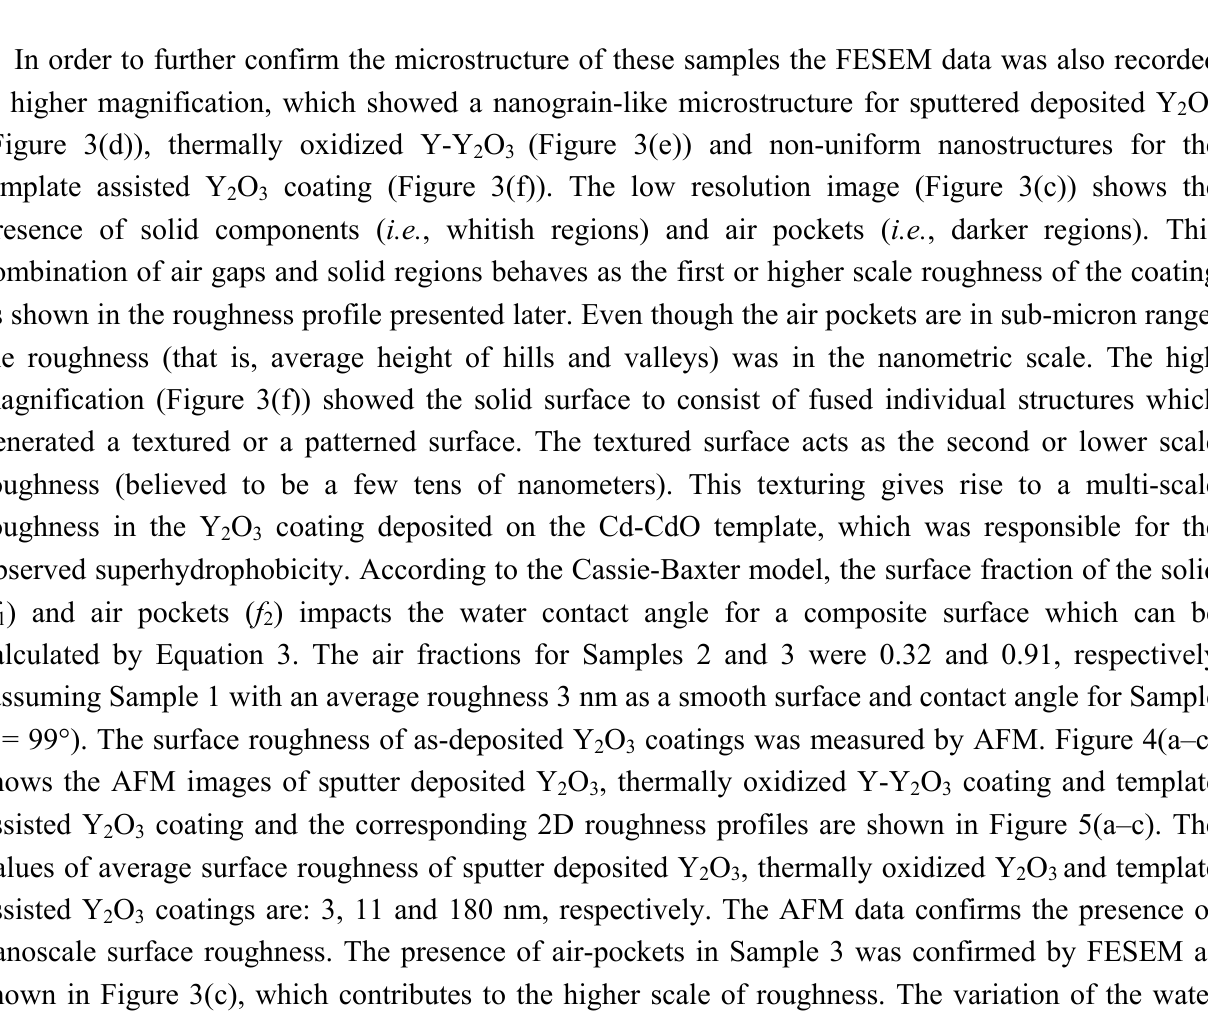
O coating, and ( c ) template assisted Y 2 3